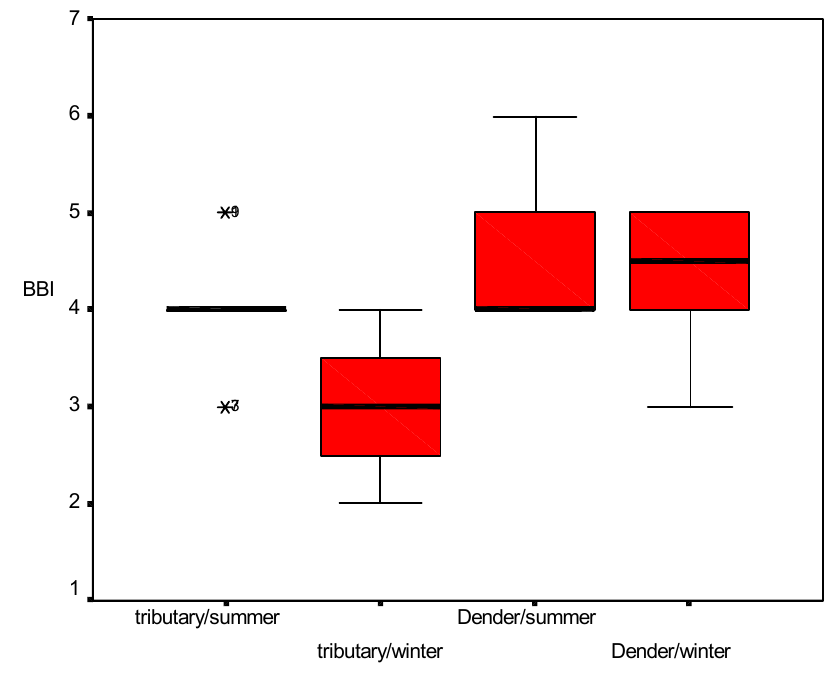
FIGURE 7. Boxplot of the BBI in summer and winter after splitting according to (cid:147)river